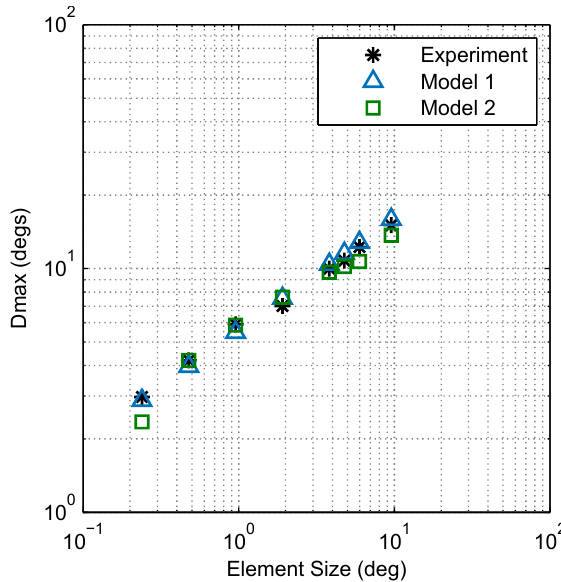
Figure 11. Comparison between Models 1 and 2. Plots of Dmax vs. element size for Models 1 and 2 show that both are in good agreement with experimental results (Model 1 has a standard error of the regression of S = 0.613 ◦ and Model 2 has S = 0.967 ◦